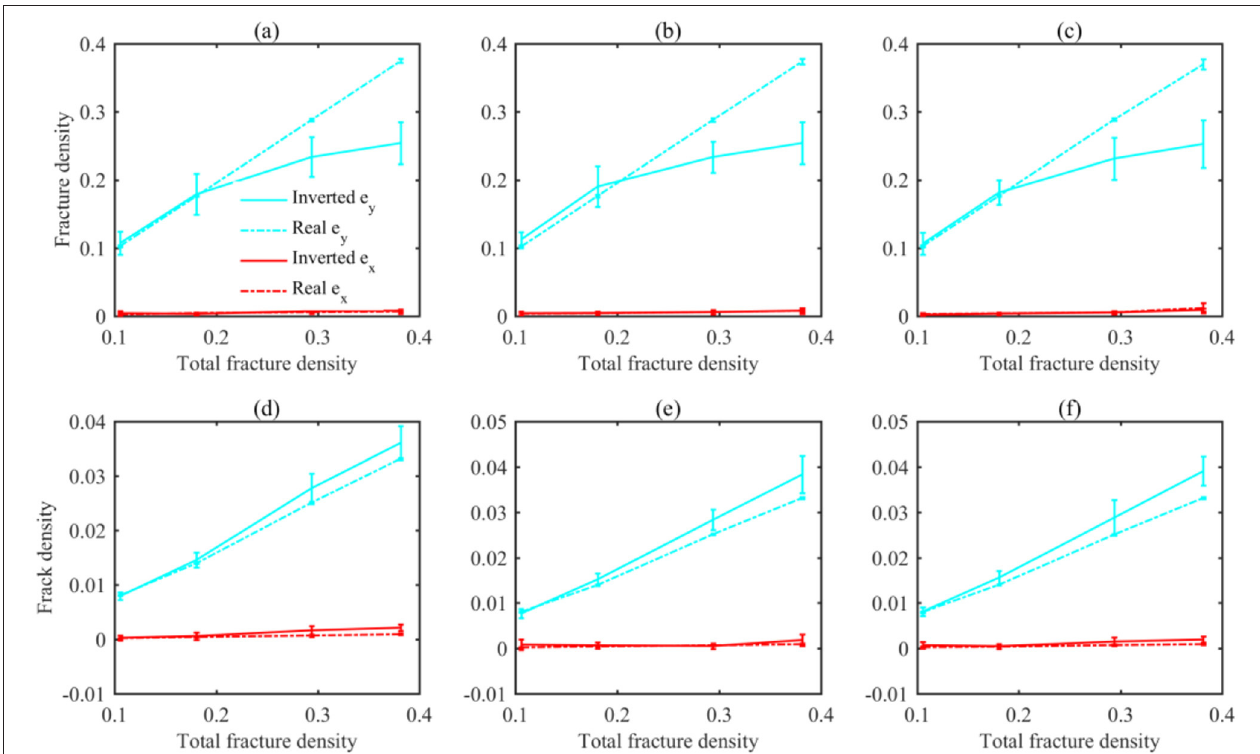
FIGURE 12 | Principal fracture densities e x and e y for different models. (A) a = 1.5, 4 = 0.71; (B) a = 1.5, 4 = 0.86; (C) a = 1.5, 4 = 1; (D) a = 3, 4 = 0.71; (E) a = 3, 4 = 0.86; (F) a = 3, 4 = 1. The solid line corresponds to the inverted result. The numerical result bars are in line with those in Figure 6 . The dashed line corresponds to e x and e y predicted as eigenvalues of the density tensor illustrated by Equation 10